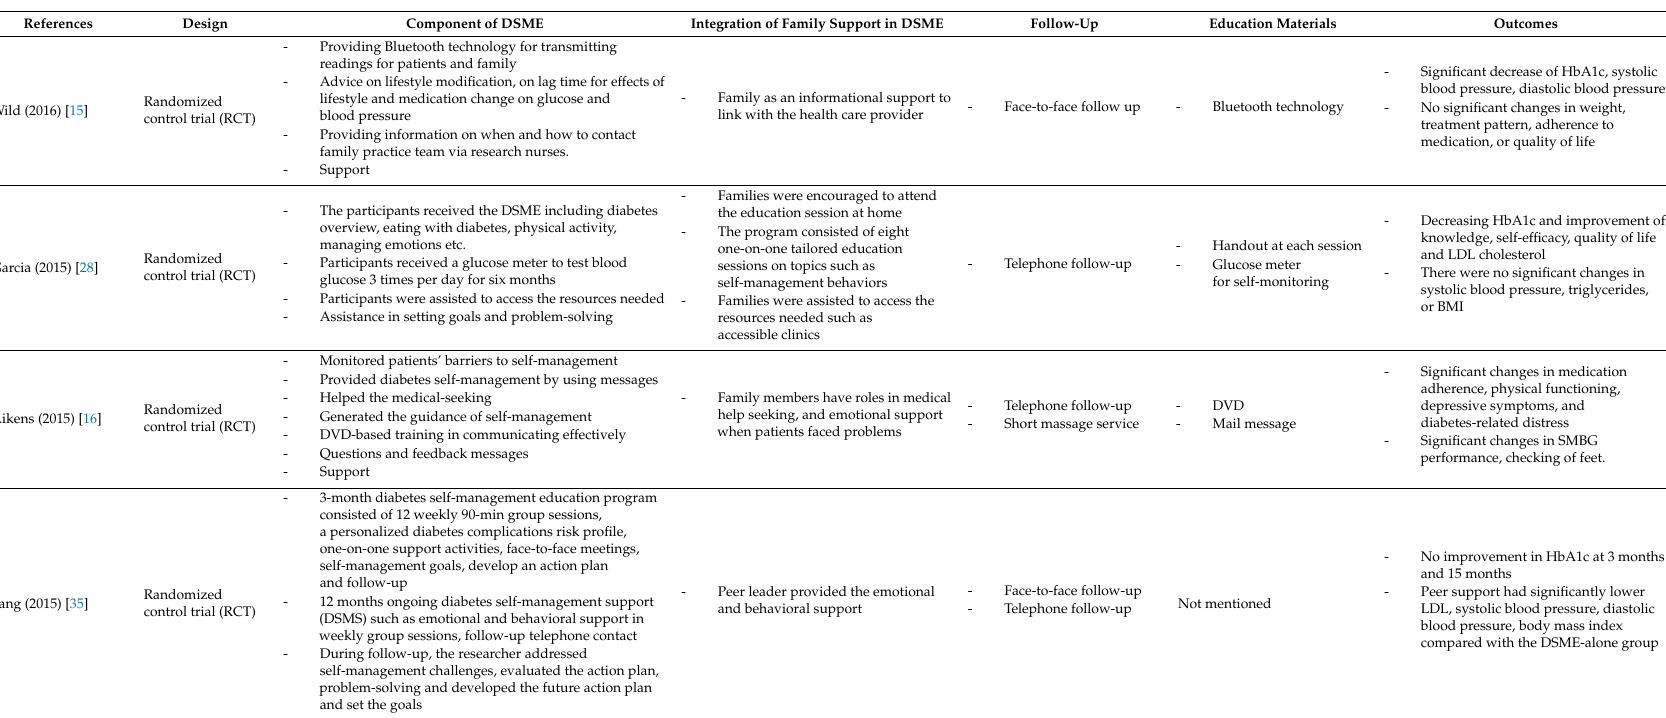
Table 1. Family support integrated with diabetes self-management and health